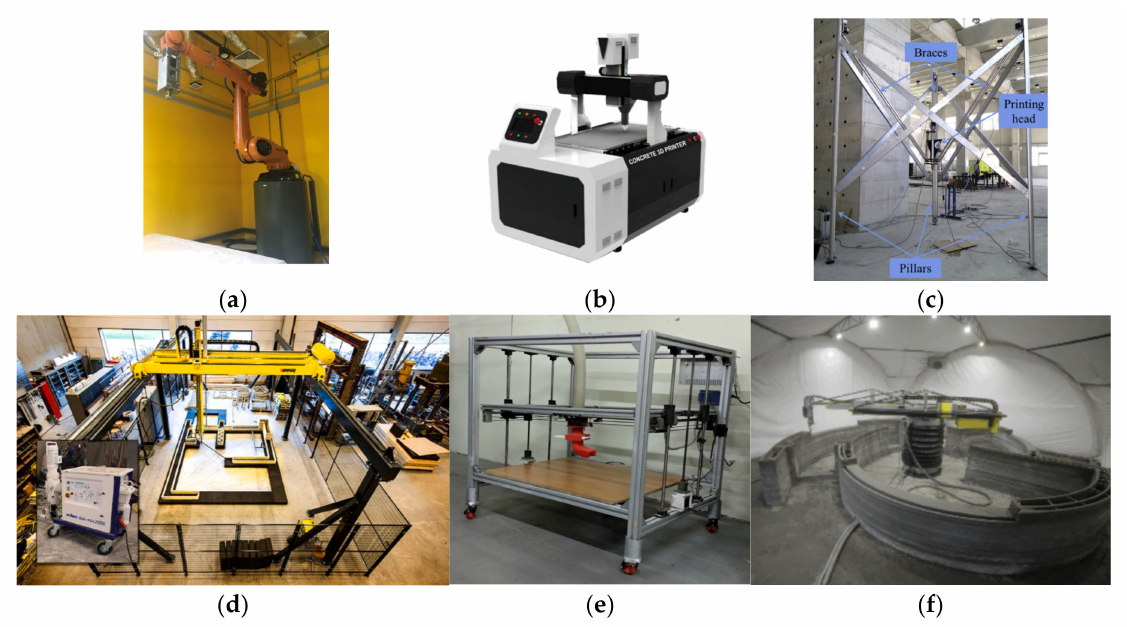
Figure 4. Motion systems in existing 3D printing systems, reprinted with permissions: ( a ) a robot arm [35], ( b ) a desktop gantry printer [23], ( c ) the delta motion system [51], ( d ) a room-size gantry printing system [25], ( e ) a frame motion system [53], and ( f ) a polar motion system